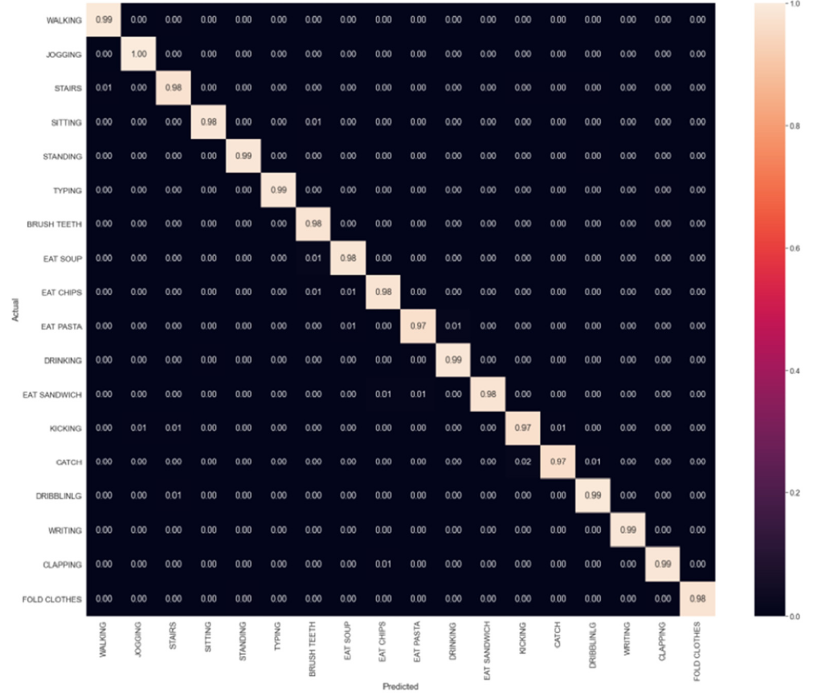
Figure 8. The confusion matrix for the classification of eighteen activities for the RELM algorithm. Table 7. The performances of the SLFN with the RELM algorithm for 18 types of physical activities. Precision Recall (%)